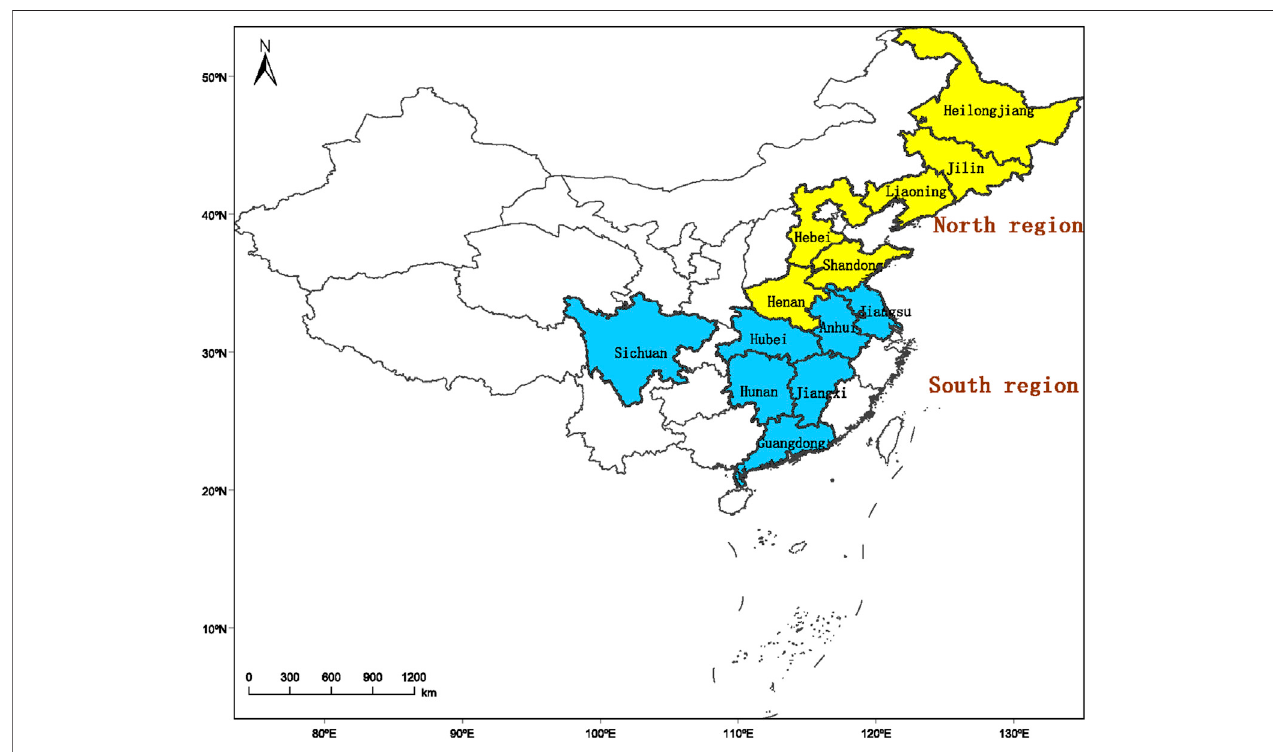
FIGURE 4 | The main grain-producing areas in China. The yellow area presents the North region, and the blue area shows the South region.